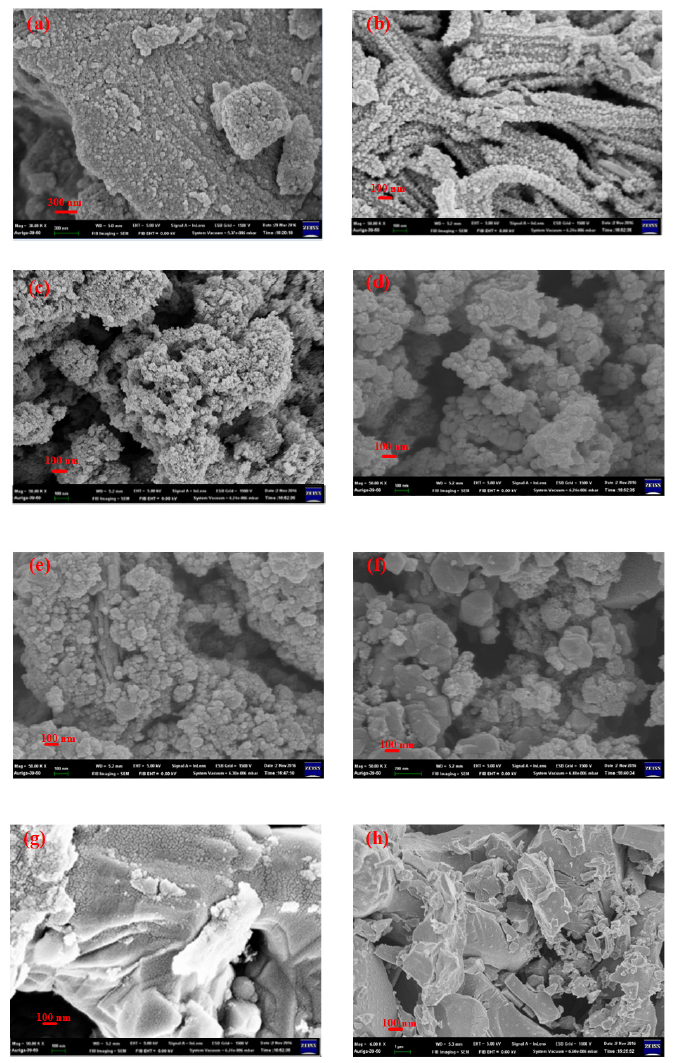
Figure 4. SEM micropictures of ( a ) Fe 3 O 4 (OA), ( b ) PANI(EB)-Em/Fe 3 O 4 (OA), ( c ) PANI(EB)/Fe 3 O 4 (OA), ( d ) FeNC-650, ( e ) FeNC-700, ( f ) FeNC-800, ( g ) FeNC-900, ( h ) FeNC-950.